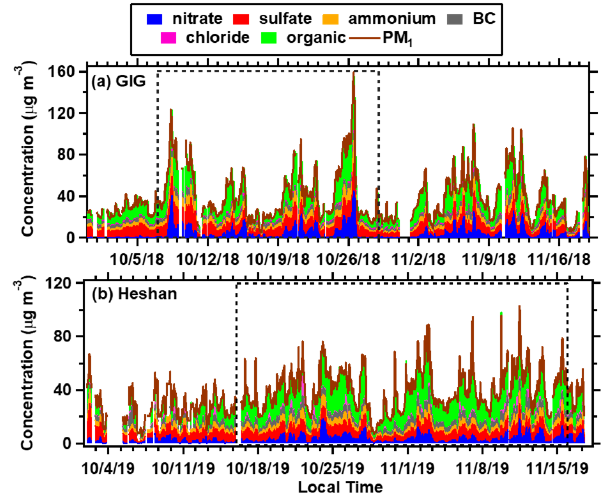
Figure 2. Temporal variations of the mass concentration of the ma- jor chemical components in PM 1 including nitrate (NO − (SO 2 − ), ammonium (NH + ), black carbon (BC), chloride (Cl − ), 4 4 and organics at (a) GIG site and (b) Heshan site. The black dashed rectangle represents the investigated period which had complete set of data.